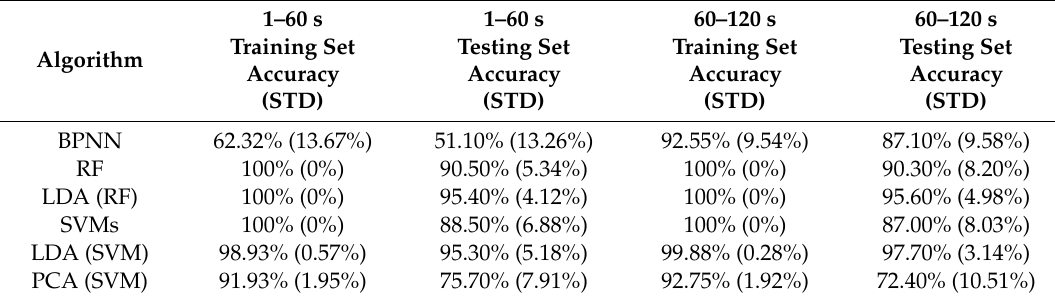
Table 3. Comparison of different algorithms.